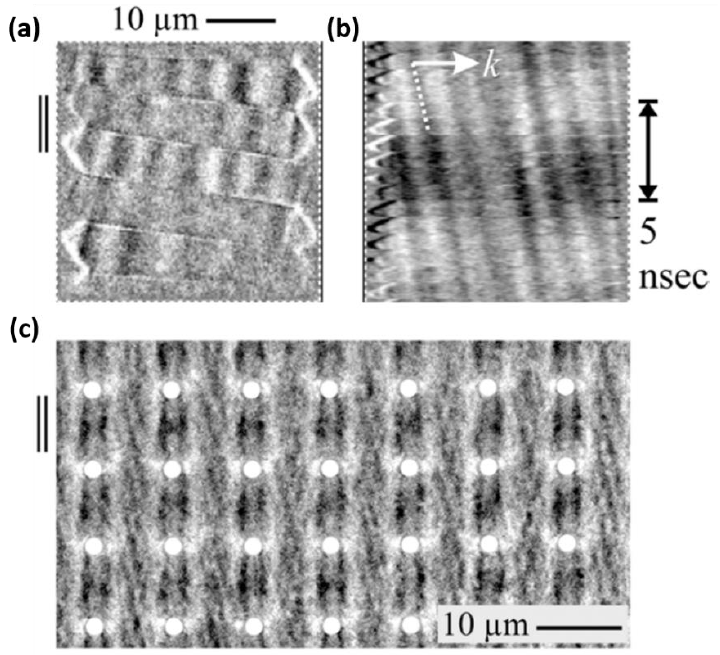
Figure 8. Domain images of magnetic dynamics for a magnetic element. ( a ) Domain wall motion at wall resonance. ( b ) Domain wall induced spin-wave propagation with time under a 100MHz field excitation. [sample: (Fe 90 Co 10 ) 78 Si 12 B 10 (160 nm)] ( c ) Imaging of standing spin-wave modes in a Co 40 Fe 40 B 20 /Ru/ Co 40 Fe 40 B 20 anti-dot array at 2 GHz. Reprinted with permission from [93]. Copyright [2015], American Physical Society.